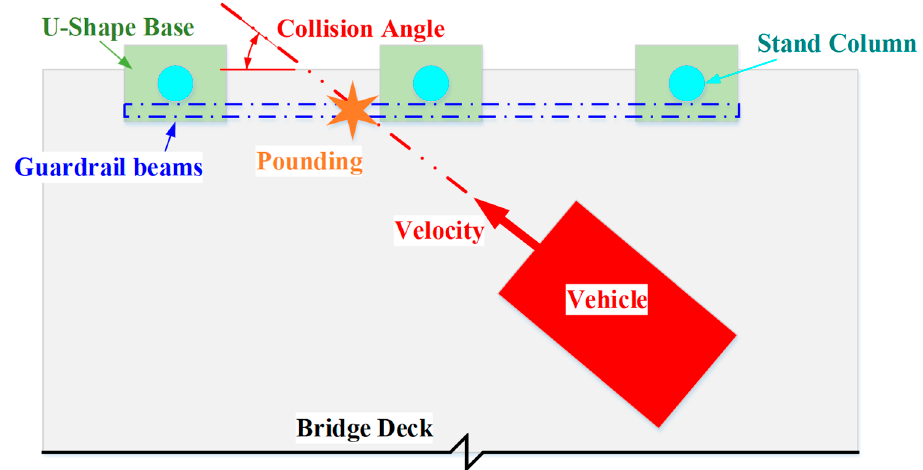
Figure 5. Collision diagram. Figure 5. Collision